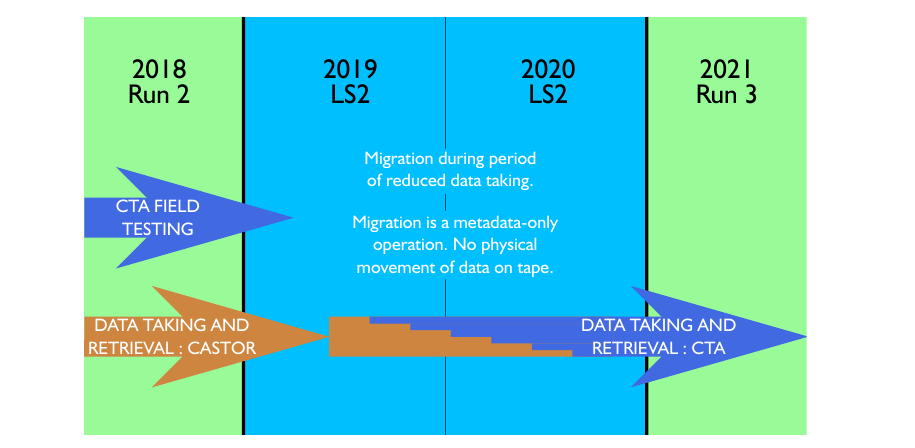
Figure 6. CASTOR to CTA Migration